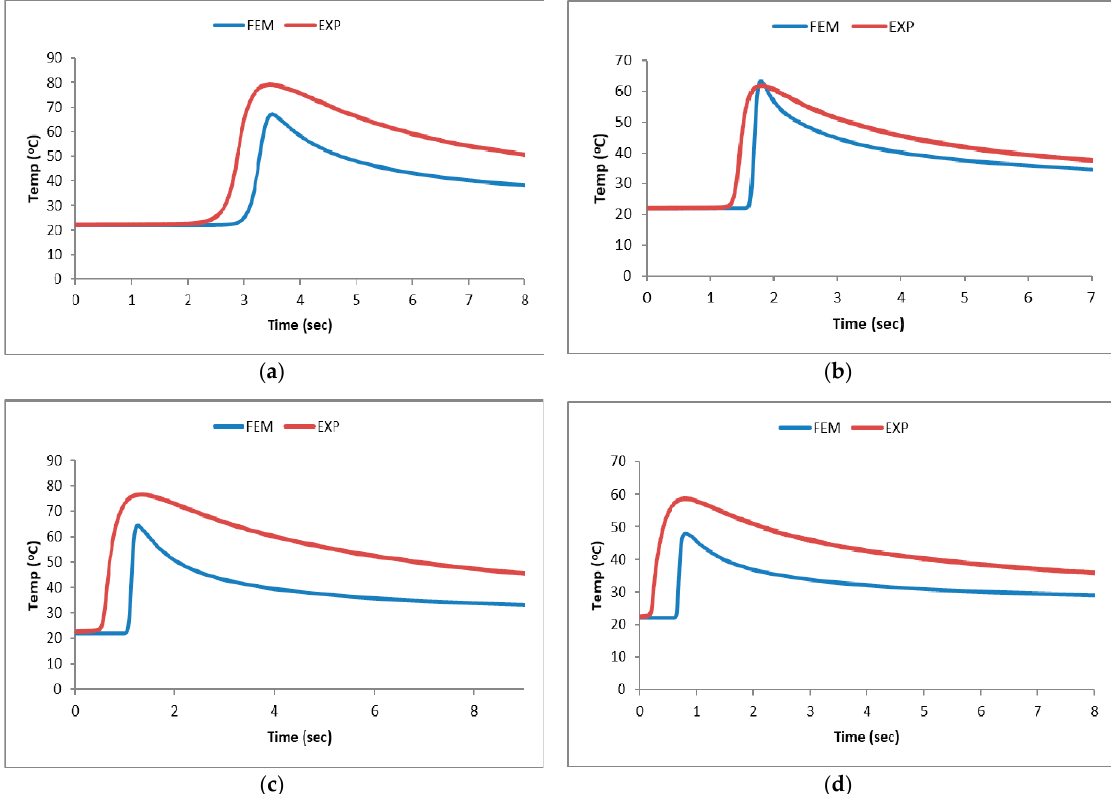
Figure 9. The temperature comparison of experimant ande FEA. ( a ) P = 100 W, Speed = 10 mm/s; ( b ) P = 100 W, Speed = 20 mm/s; ( c ) P = 250 W, Speed = 30 mm/s; and ( d ) P = 250 W, Speed = 50 mm/s.